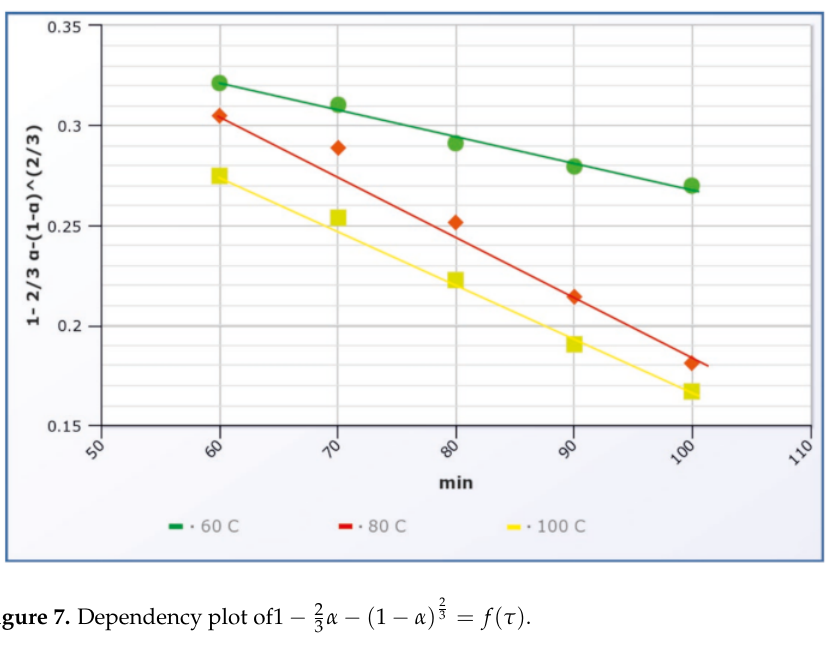
Figure 7. Dependency plot of1 − 2 The reaction rate constants are found along the tangent of the angle of the straight line to the abscissa axis shown in Figure 7: